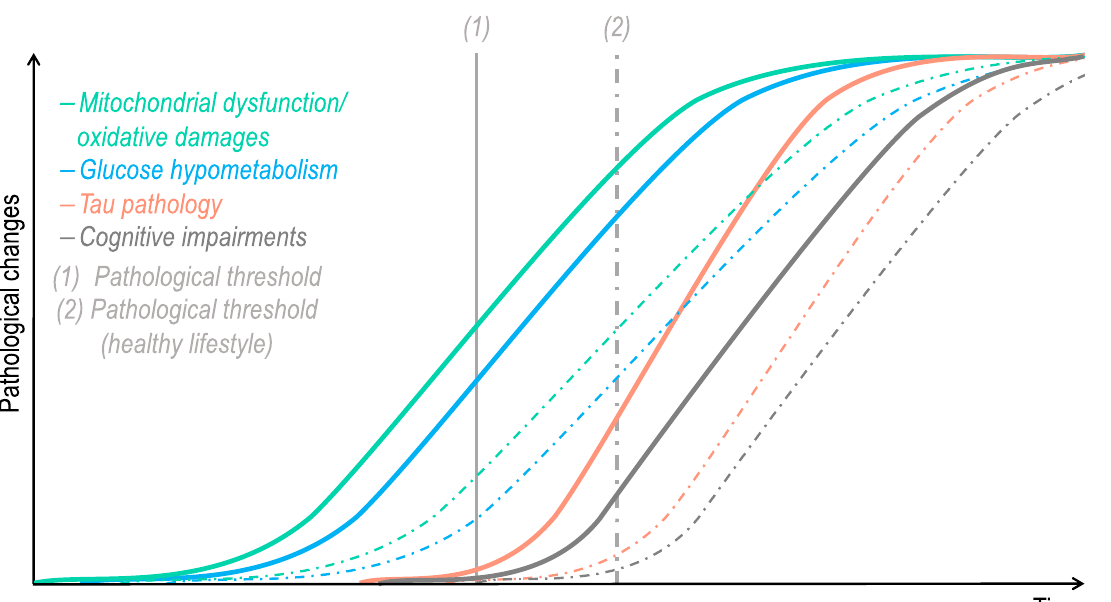
Figure 4. Hypothetical time course of pathological changes in Alzheimer’s disease-related tauopathy. Impairments in mitochondrial function, oxidative stress, and glucose hypometabolism are features that are observed in “normal” aging. One can hypothesize that after passing a pathological threshold (1), which differs according to each individual lifestyle/genetic background, these age-related bioenergetic defects trigger tau pathology. In turn, abnormal tau exacerbates brain bioenergetic dysfunctions, precipitating cognitive impairments and dementia. The dotted lines represent pathological changes that would be delayed in an individual with a healthy lifestyle, combining, among others, a healthy diet, physical activity, and cognitive stimulation.